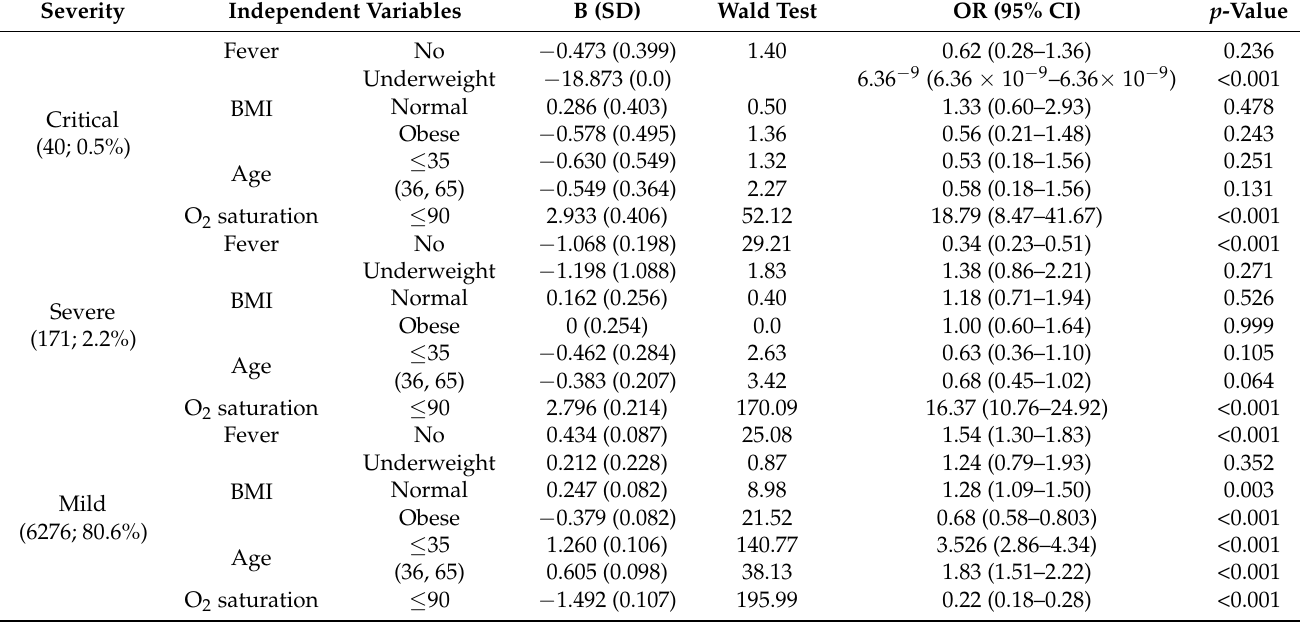
Table 4. Final multinomial logistic regression model with the “moderate” category as a